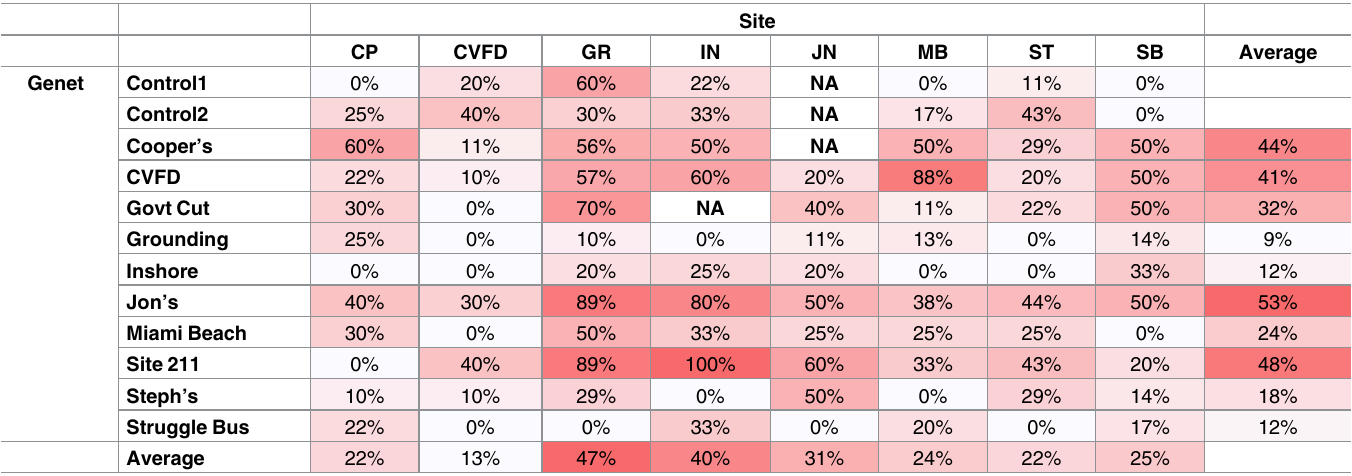
Table 3. Bleaching prevalenceof outplanted corals in